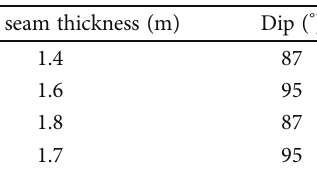
Figure 2: Layout drawing of drilling in the underground coal mine. Table 2: Borehole construction settings and